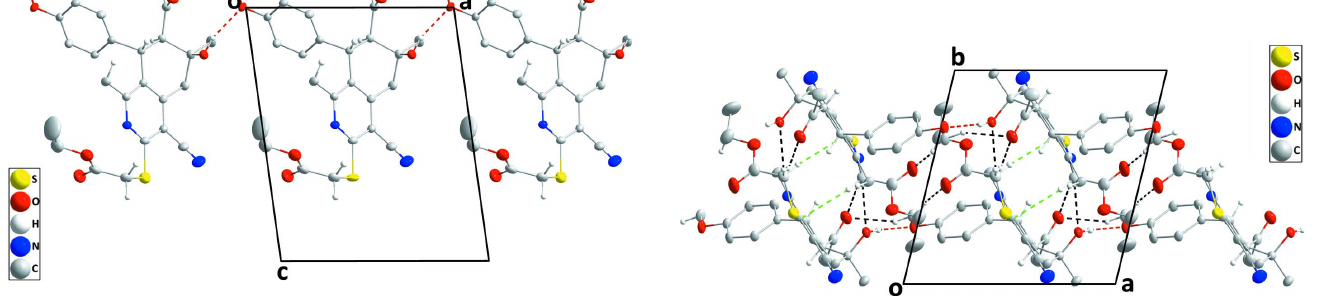
Figure 3 Packing viewed along the c -axis direction giving an elevation view of one layer. Hydrogen bonds are depicted as in Fig. 2 while C—H (cid:2)(cid:2)(cid:2) (cid:2) (ring) interactions are indicated by green dashed